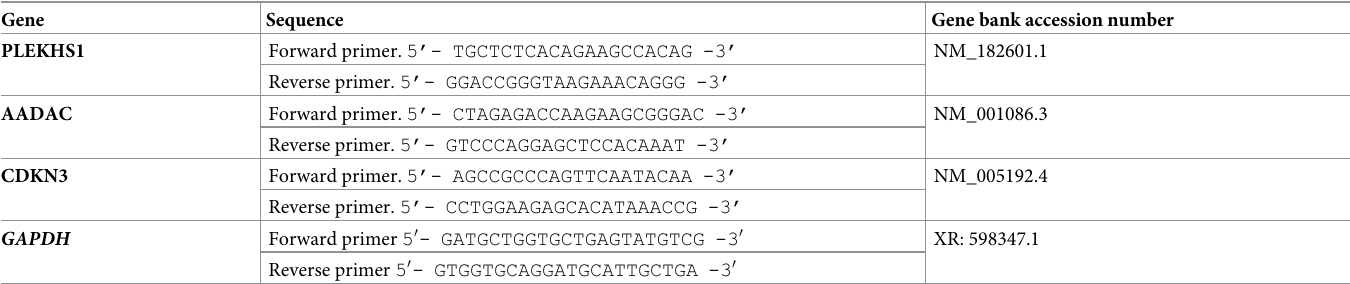
Table 2. PCR primers. Gene